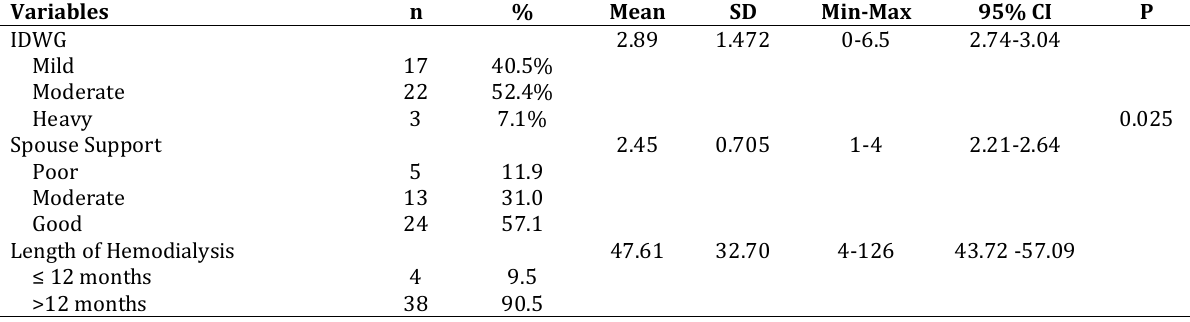
Table 2. IDWG Relationship with Spousal Support and the Length of Hemodialysis